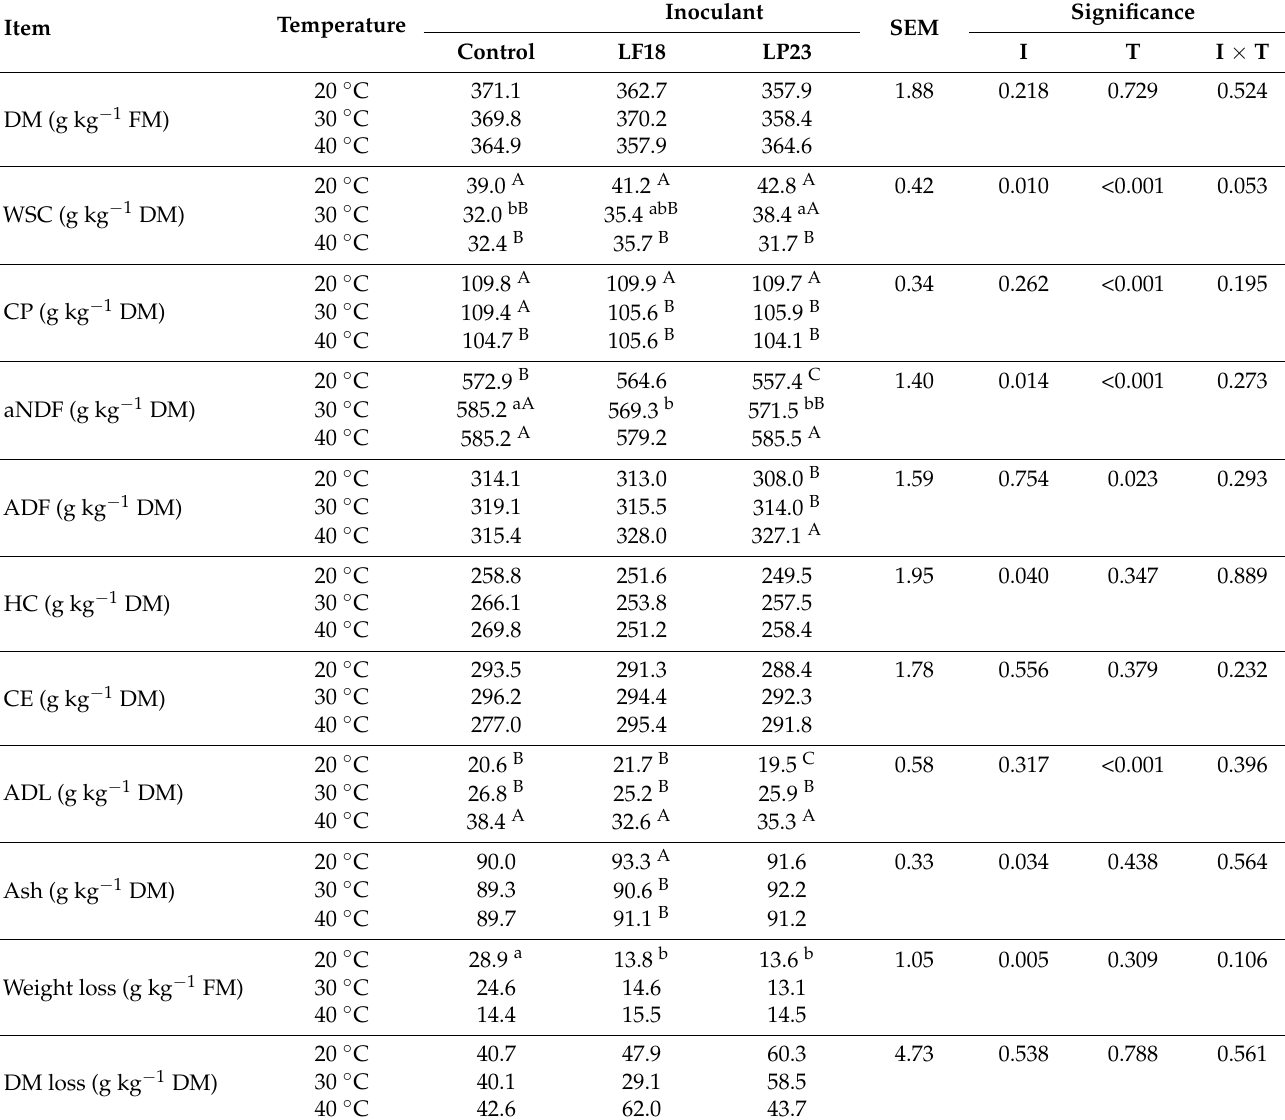
Table 2. Chemical compositions of sorghum